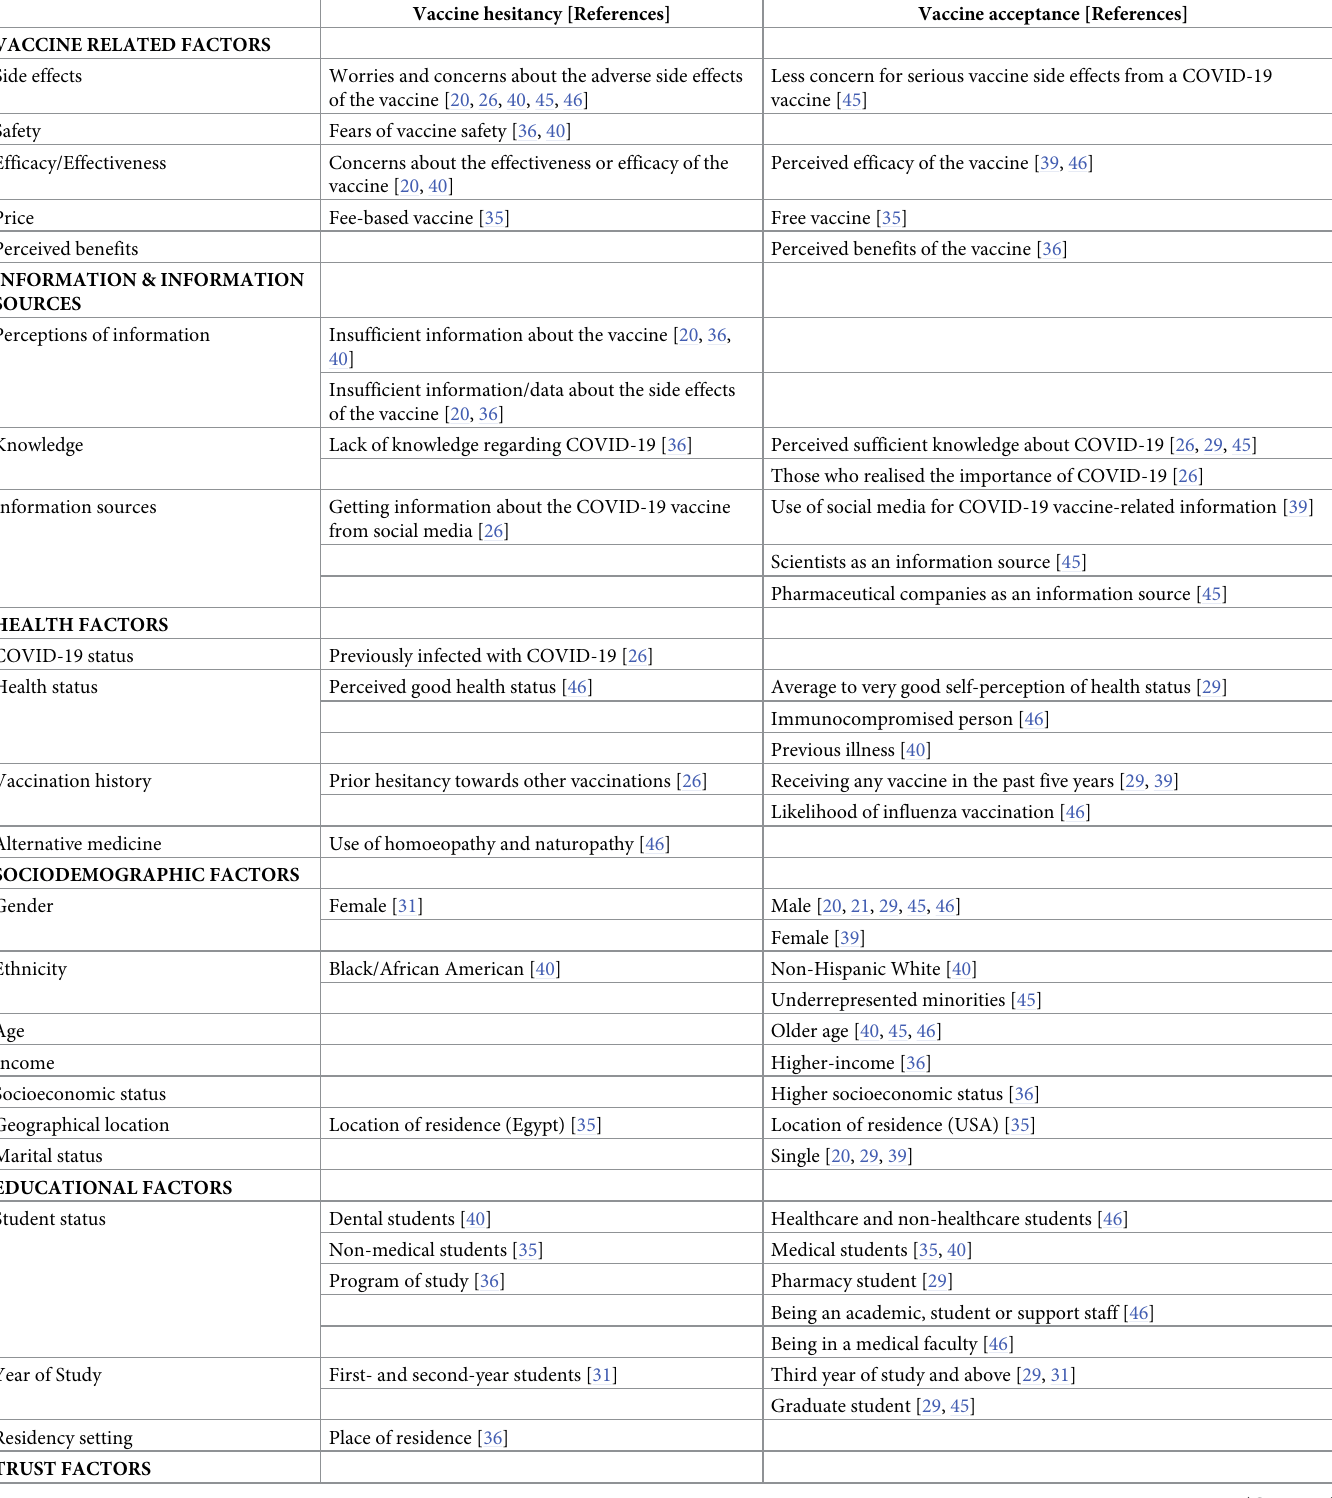
Table 6. Factors associated with vaccine hesitancy and vaccine acceptance for healthcare